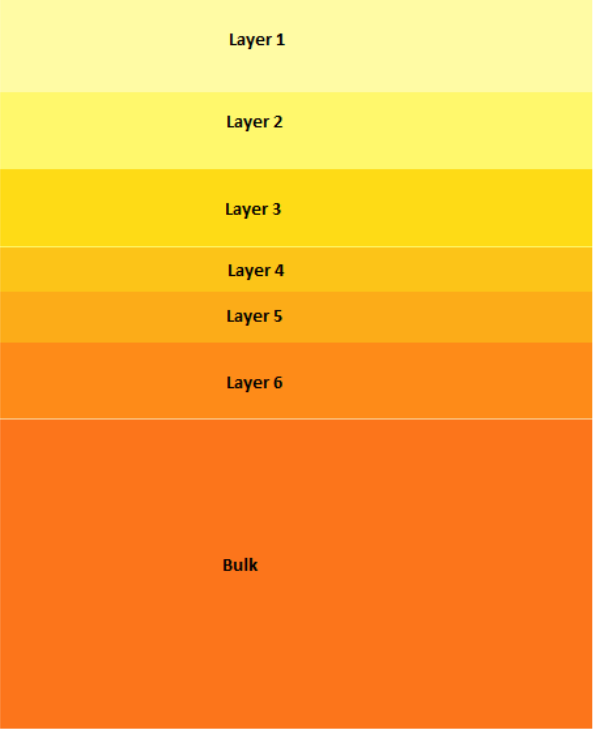
Figure 3. Schematization of a seven-layer structure used for Monte Carlo